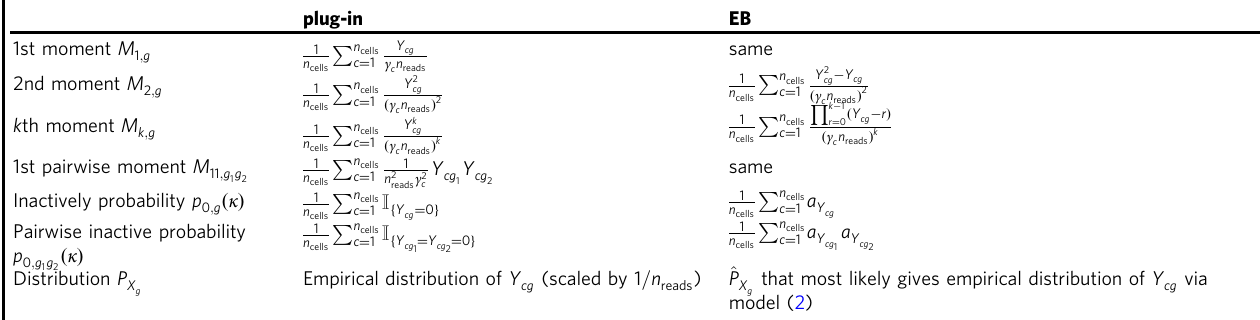
Thetwo estimatorsarewritten insimilarformsforbetter comparison.For theinactiveprobability(andthe pairwisecase), a Y Supplementary Note 5 for the exact expression and other